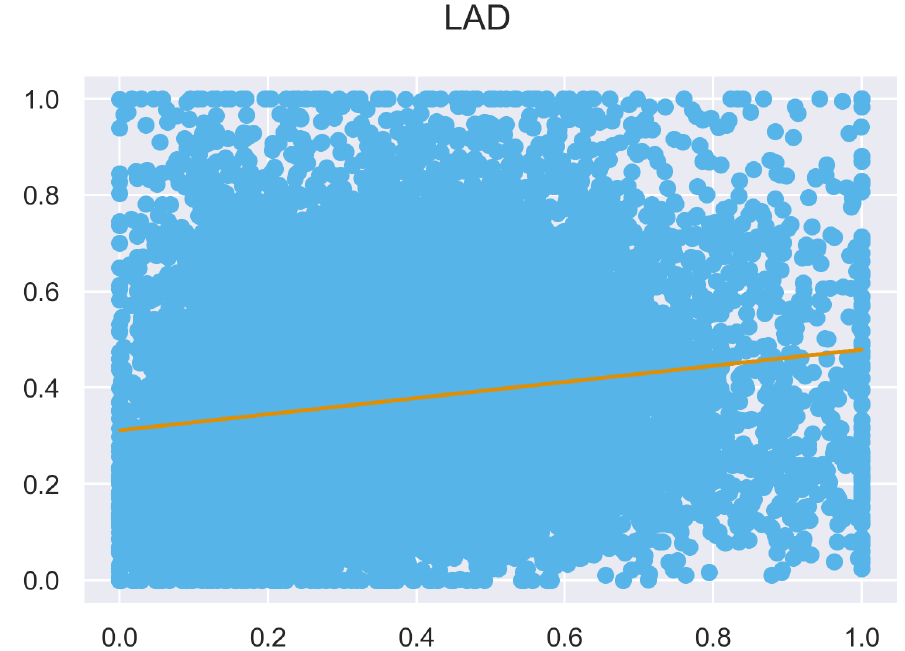
Figure A11. ULS and TLS LAD regression at 0.5 m grid size.